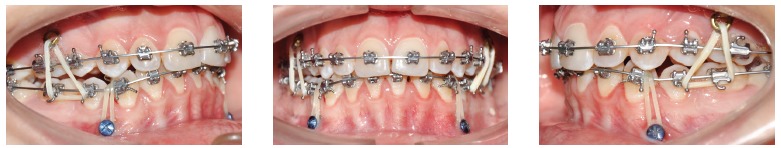
Post-surgical occlusion.